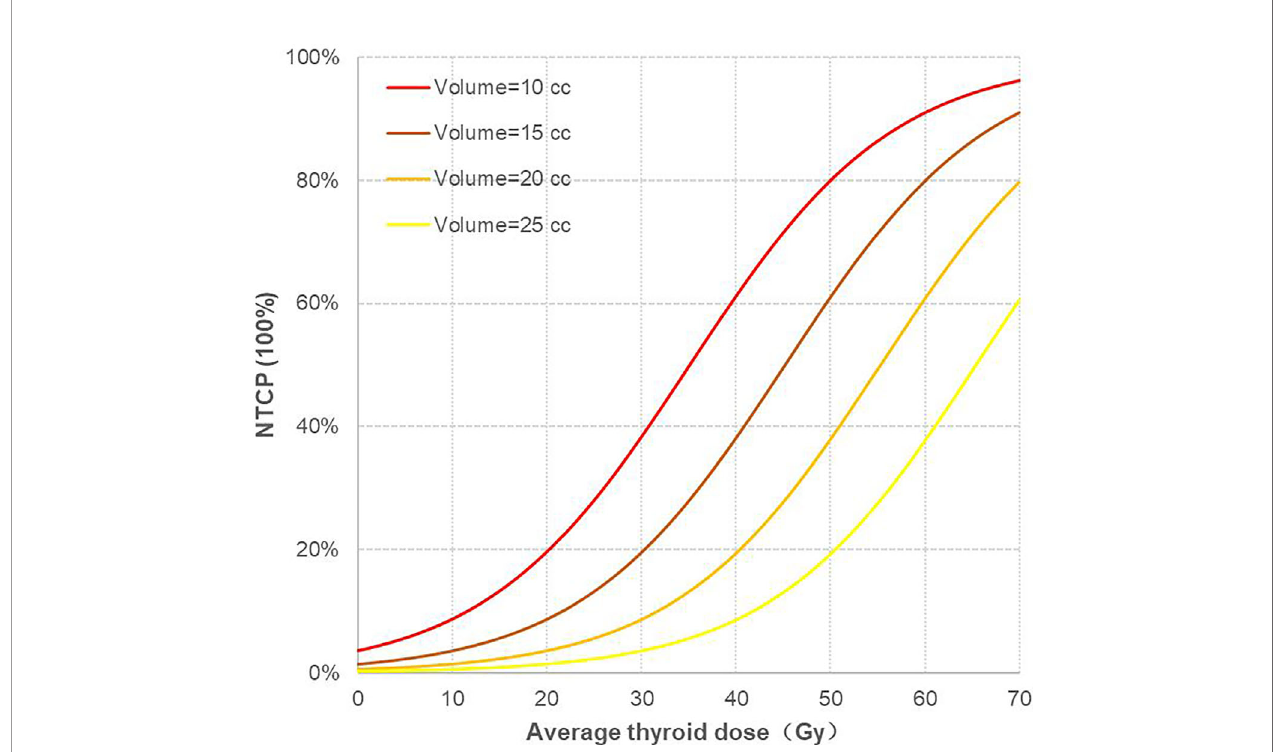
FIGURE 3 | Corresponding NTCP curves of four different thyroid volume levels. NTCP, normal tissue complication